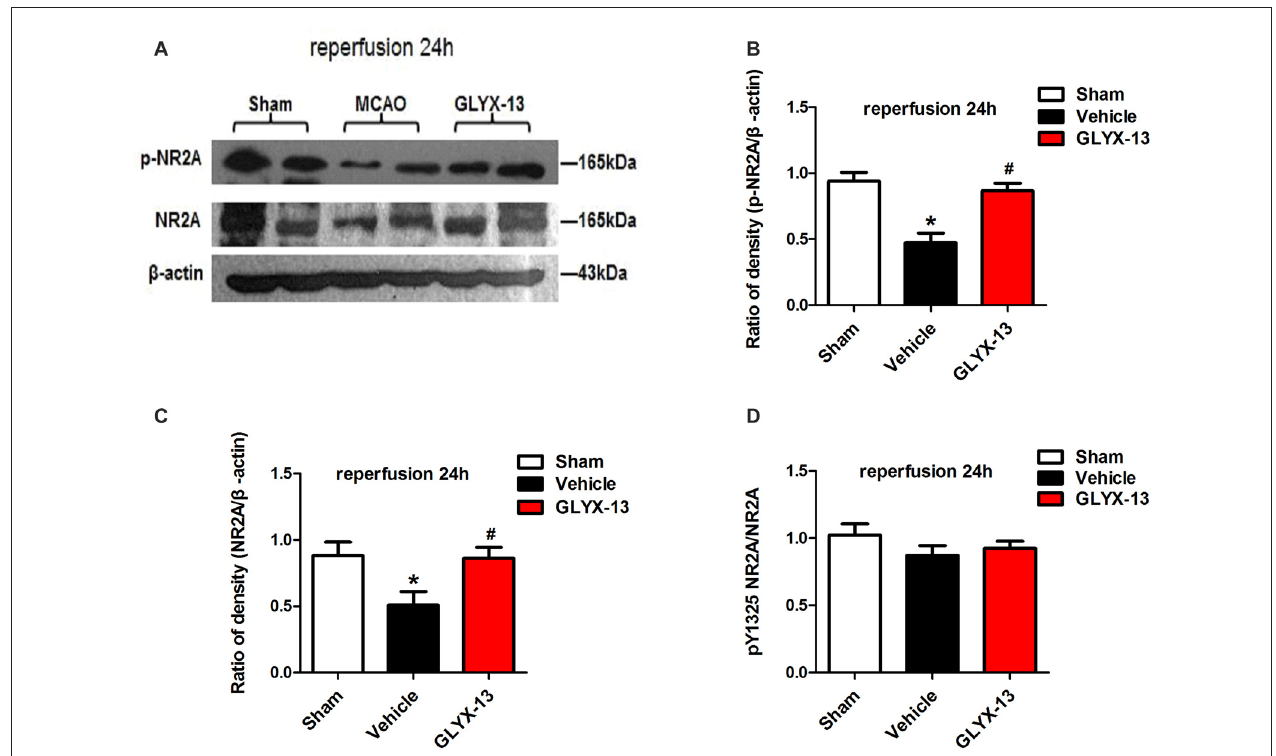
FIGURE 7 | GLYX-13 ameliorated the loss of NR2A after 24 h reperfusion. (A) Representative images of western blot. The intensity of each band was quantified by Image j and normalized in relation to β -actin. (B–D) Statistical analysis of densitometric data from indicated experimental groups. The values are expressed as mean ± SEM, n = 3 independent experiments. One-way ANOVA and Newman-Keuls post test, ∗ p < 0.05, vs. Sham; # p < 0.05, vs.